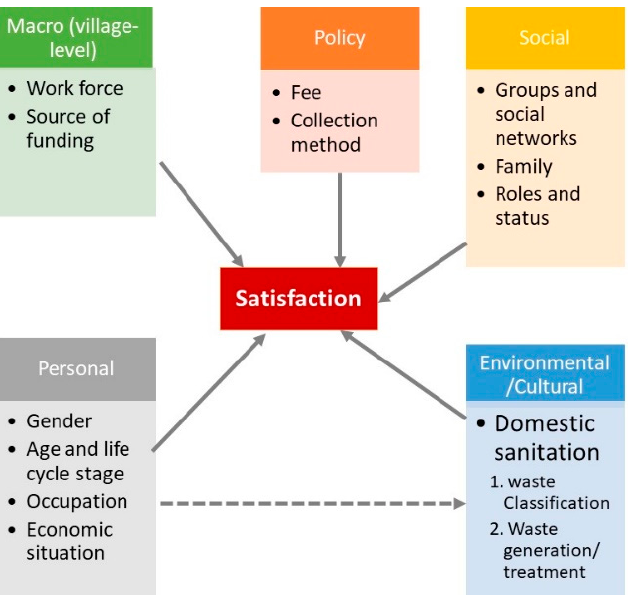
Figure 1. Theoretical framework of satisfaction with rural waste management services (partially adopted from [49]).